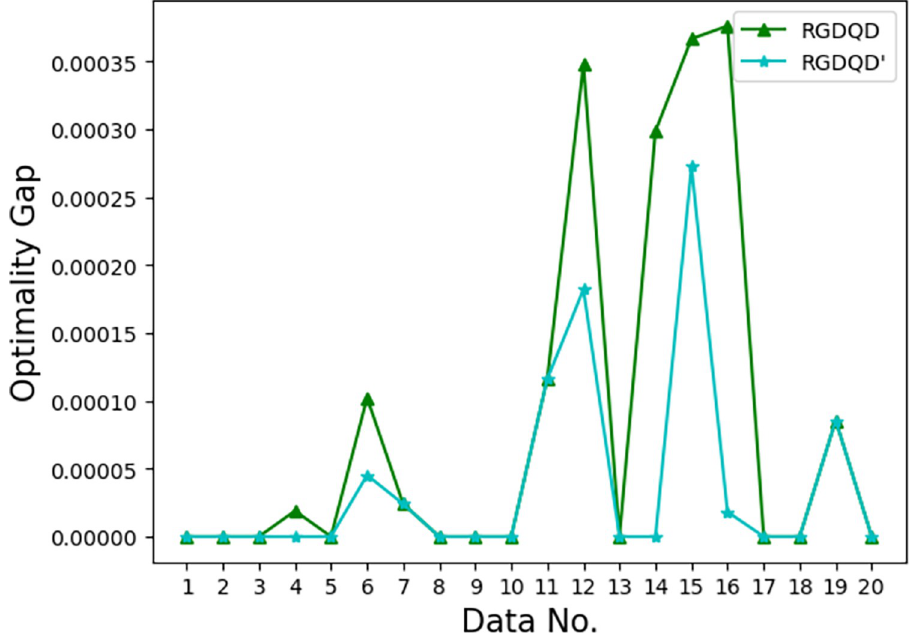
Fig 13. Comparison of optimality gaps for RGDQD and